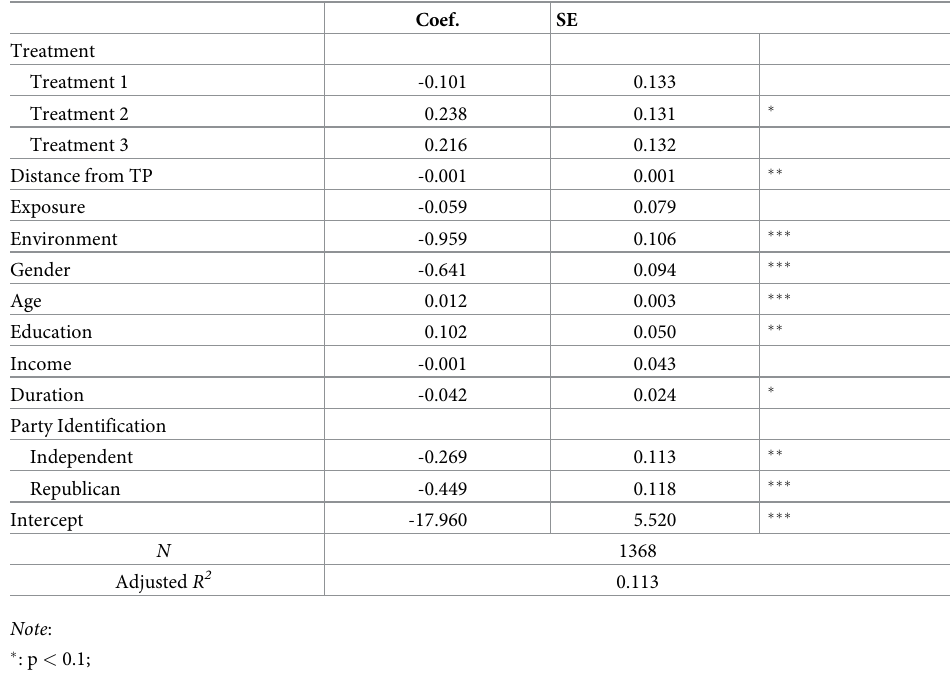
Table 1. Main result.